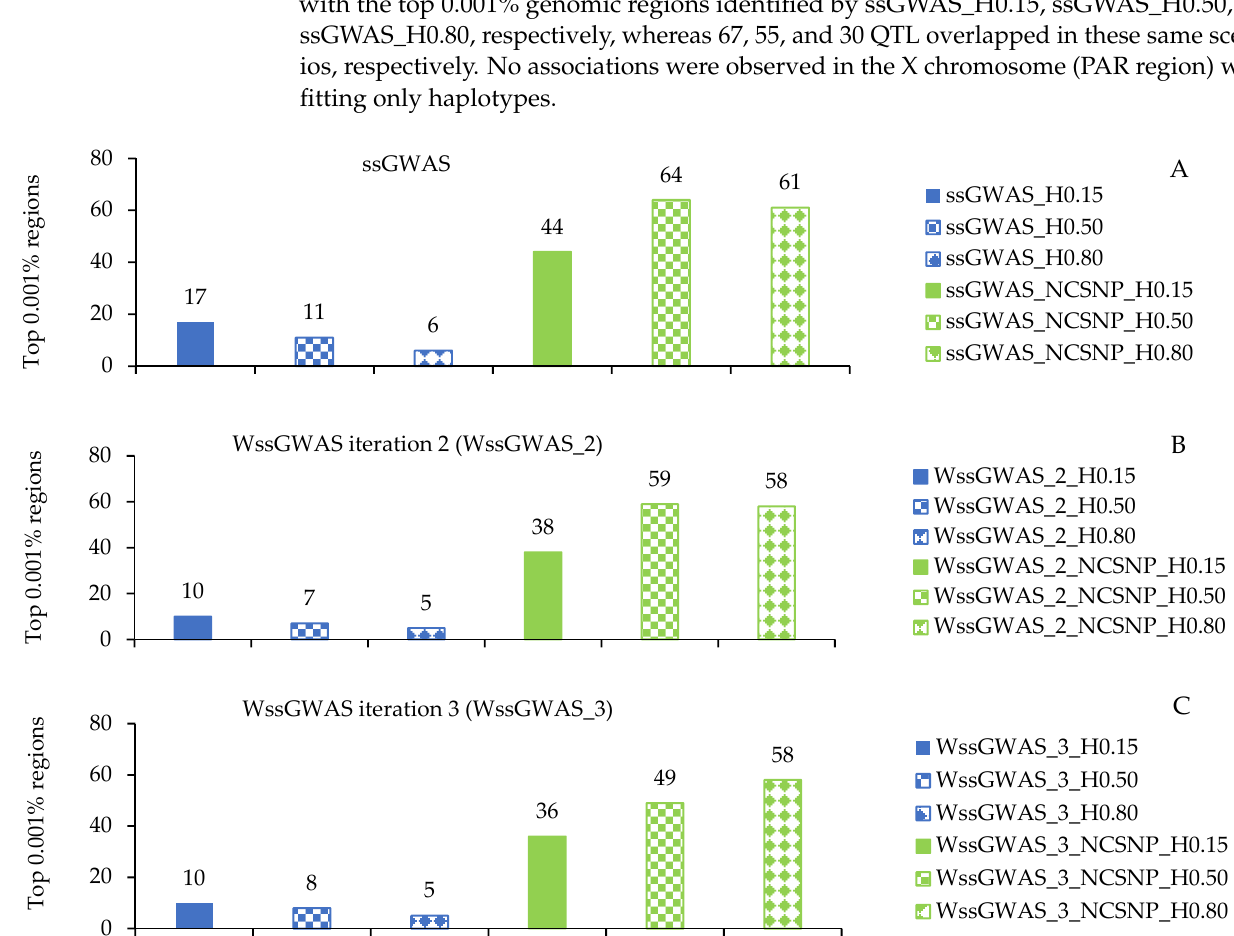
Figure 1. Number of top 0.001% genomic regions for yearling temperament in American Angus cattle found by non-weighted single-step GWAS (ssGWAS) ( A ) and weighted ssGWAS (WssGWAS) in the second ( B ) and third ( C ) iterations. H0.15, H0.50, and H0.80: only haplotypes from blocks with linkage disequilibrium (LD) thresholds of 0.15, 0.50, and 0.80, respectively; NCSNP_H0.15, NCSNP_H0.50, and NCSNP_H0.80: non-clustered SNPs (NCSNP) and haplotypes from blocks with LD thresholds of 0.15, 0.50, and 0.80, respectively. The column colors highlight not including (blue) or includ- ing NCSNP (green). The column filling highlights different LD thresholds (0.15, 0.50, and 0.80 with a solid, square, and diamond filling, respectively).